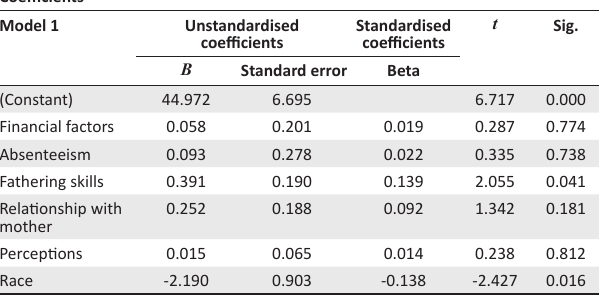
TABLE 3: Summary of multiple regression showing relative contributions of independent variables on the challenges faced by children. Model 1